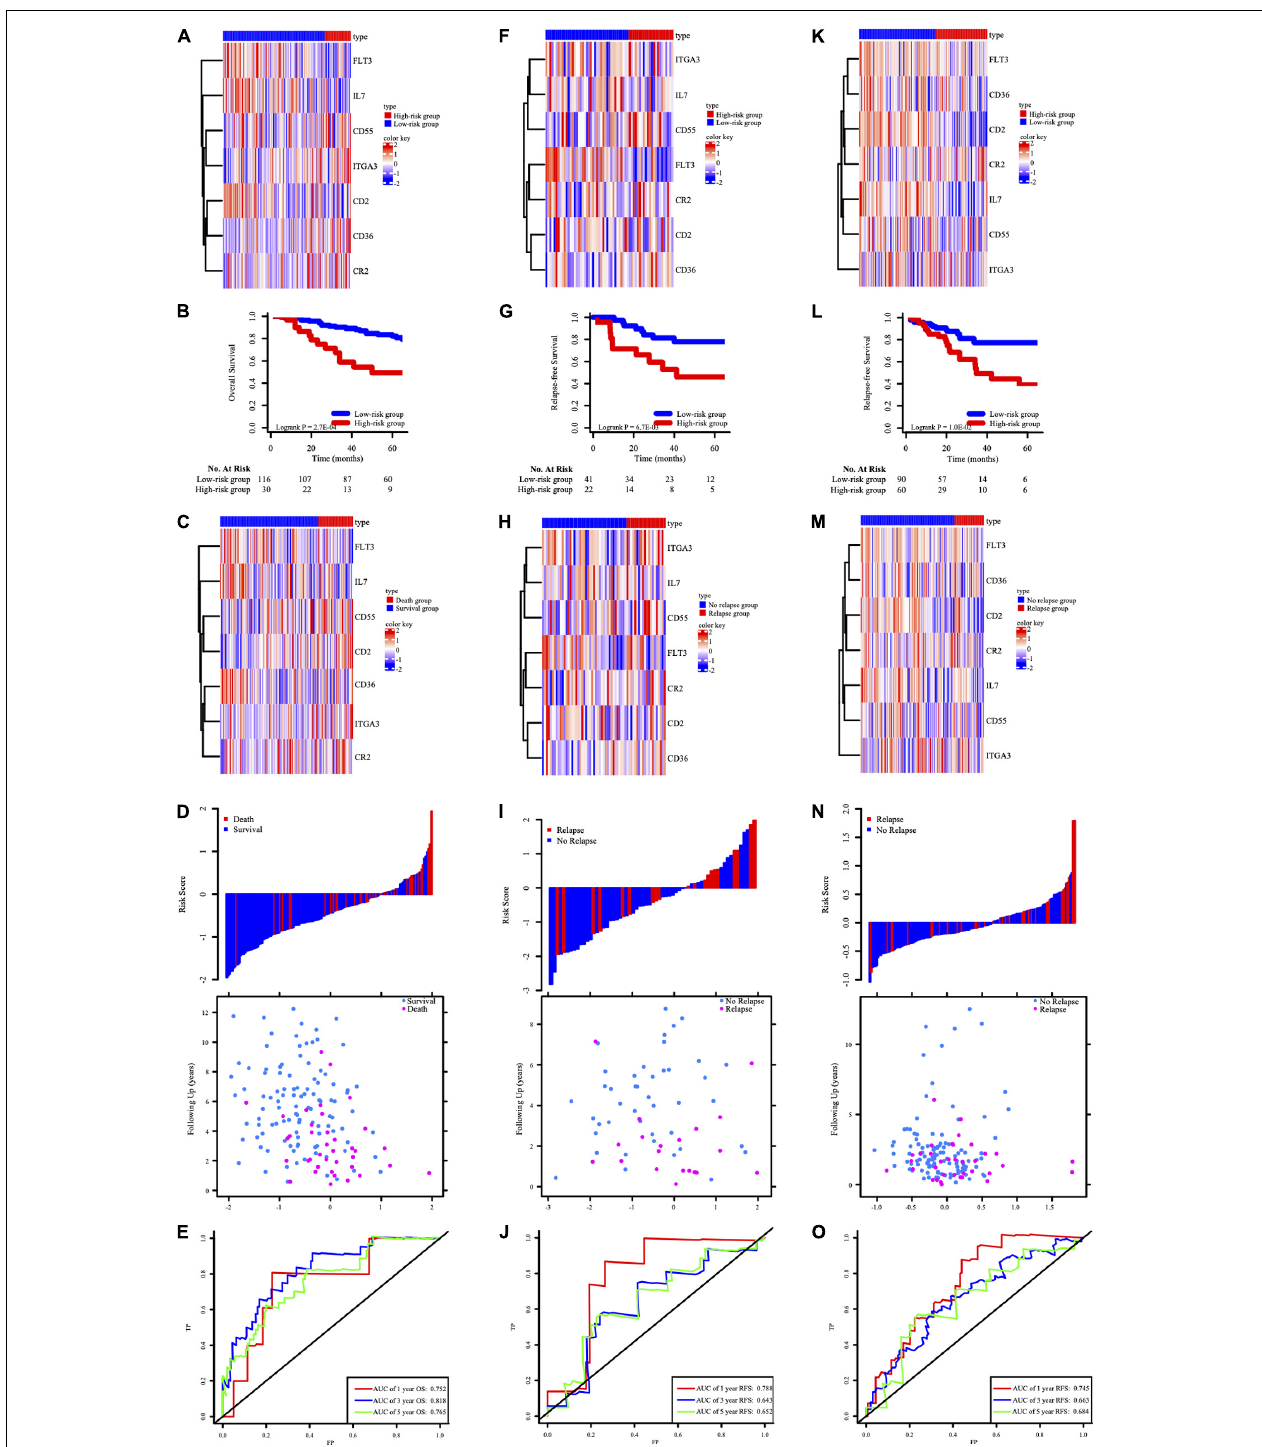
FIGURE 4 | The expression pattern of the seven-HCL-related signature based on risk groups in the GSE39582 OS cohort (A) , GSE14333 RFS cohorts (F) , and TCGA RFS cohorts (K) . The K-M survival curves in the GSE39582 OS cohort (B) , GSE14333 RFS cohorts (G) , and TCGA RFS cohorts (L) . The expression pattern of the seven-HCL-related signature based on survival or relapse status in the GSE39582 OS cohort (C) , GSE14333 RFS cohorts (H) , and TCGA RFS cohorts (M) . The distribution of patients’ risk score and relapse status in GSE14333 (I) , and TCGA (N) . The distribution of patients’ risk score and survival status in GSE39582 (D) . AUC values of ROC for predicting response of ACT in stage III CRC patients in the GSE39582 OS cohort (E) , GSE14333 RFS cohorts (J) , and TCGA RFS cohorts (O) .